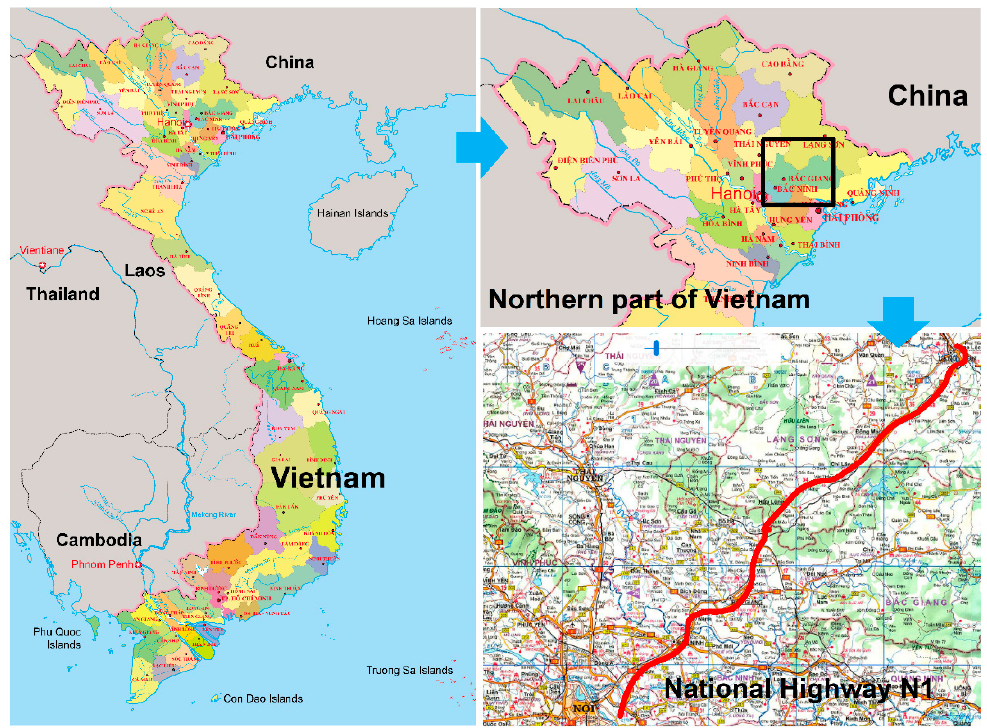
Figure 1. Location and size of the Management Department I.